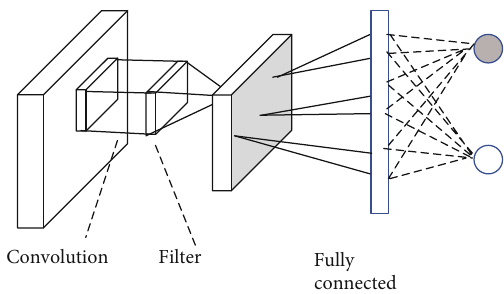
Figure 2: A typical convolutional neural network